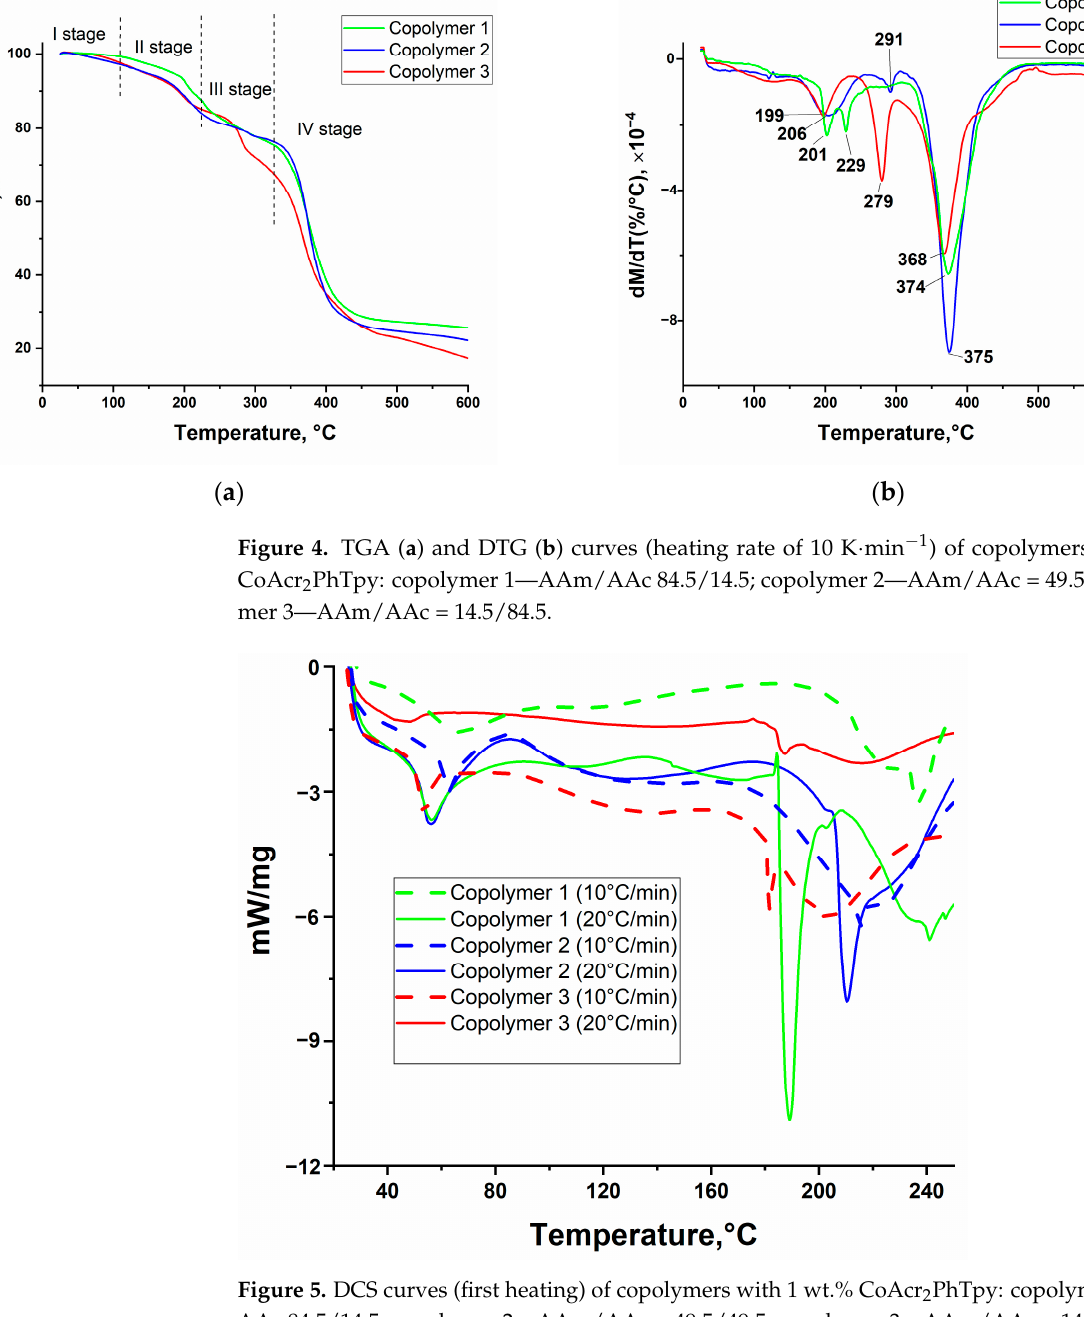
Figure 5. DCS curves (first heating) of copolymers with 1 wt.% CoAcr 2 PhTpy: copolymer